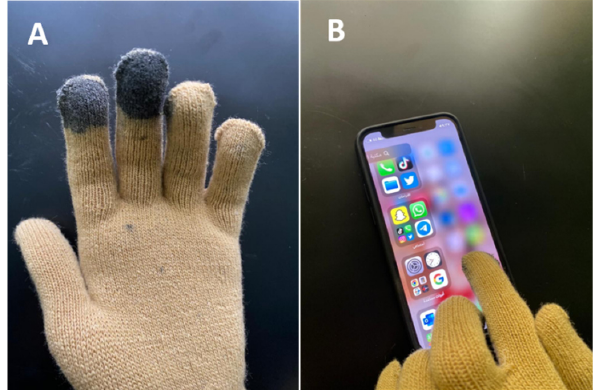
Figure 8. ( A ) Digital photograph of a graphite drop-casted glove. ( B ) Coating on the fingertip of the glove can be detected well by the touchscreen of the cell phone.